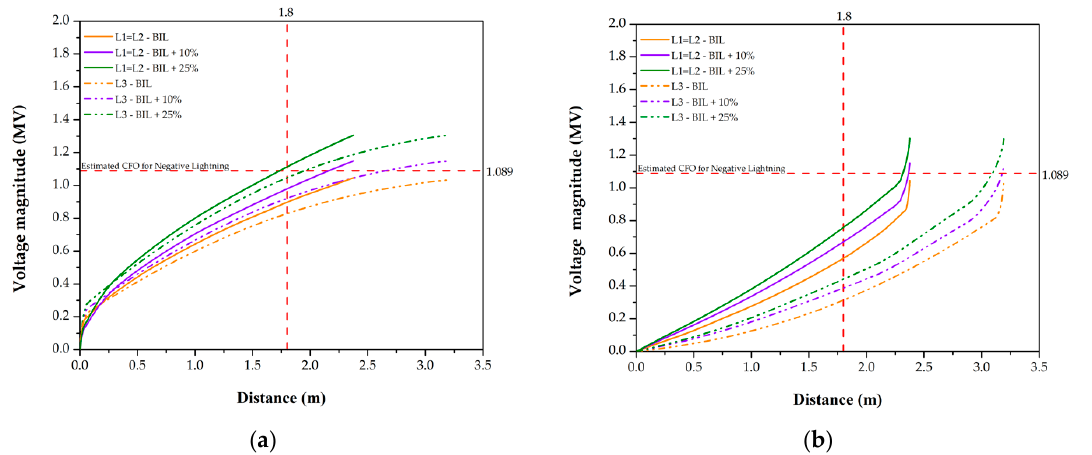
Figure 12. Voltage magnitude due to ( a ) backflashover, and ( b ) shielding failure activities. Table 10. The voltage magnitude and the percentage difference between CFO and simulation results. Phase-to-Earth Minimum Percentage Difference between Types of Overvoltages Applied BIL Clearance at Crossarm Estimated CFO and Simulations (%) Section Backflashover